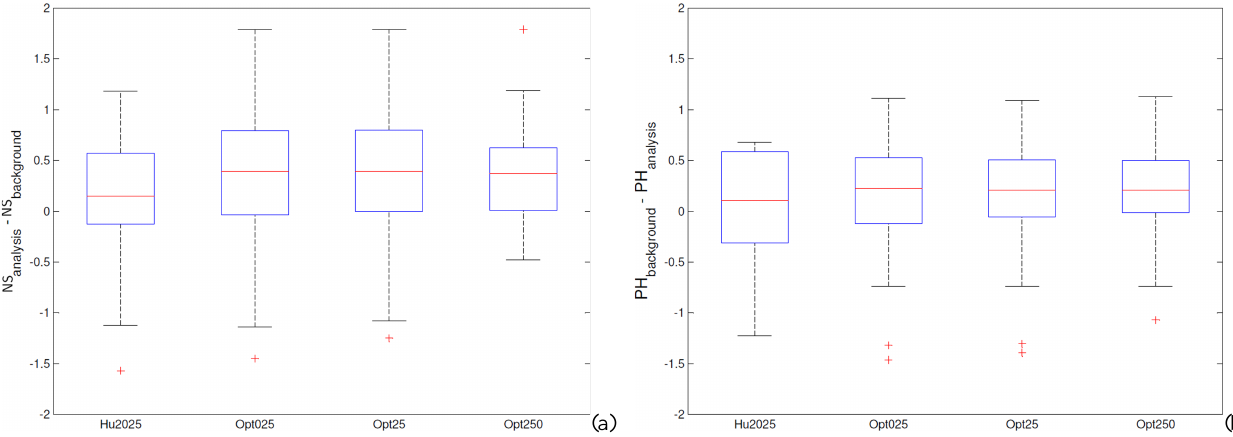
Fig. 13. Box plots of simulation performance: (a) NS analysis − NS background ; (b) PH background − PH analysis . The simulations shown are: Hu2025 ( S = S hu2 ; β obs =0.25m 6 s − 2 ), Opt025 ( S = S cal ; β obs =0.25m 6 s − 2 ), Opt25 ( S = S cal ; β obs =25m 6 s − 2 ) and Opt250 ( S = S cal ; β obs =250m 6 s − 2